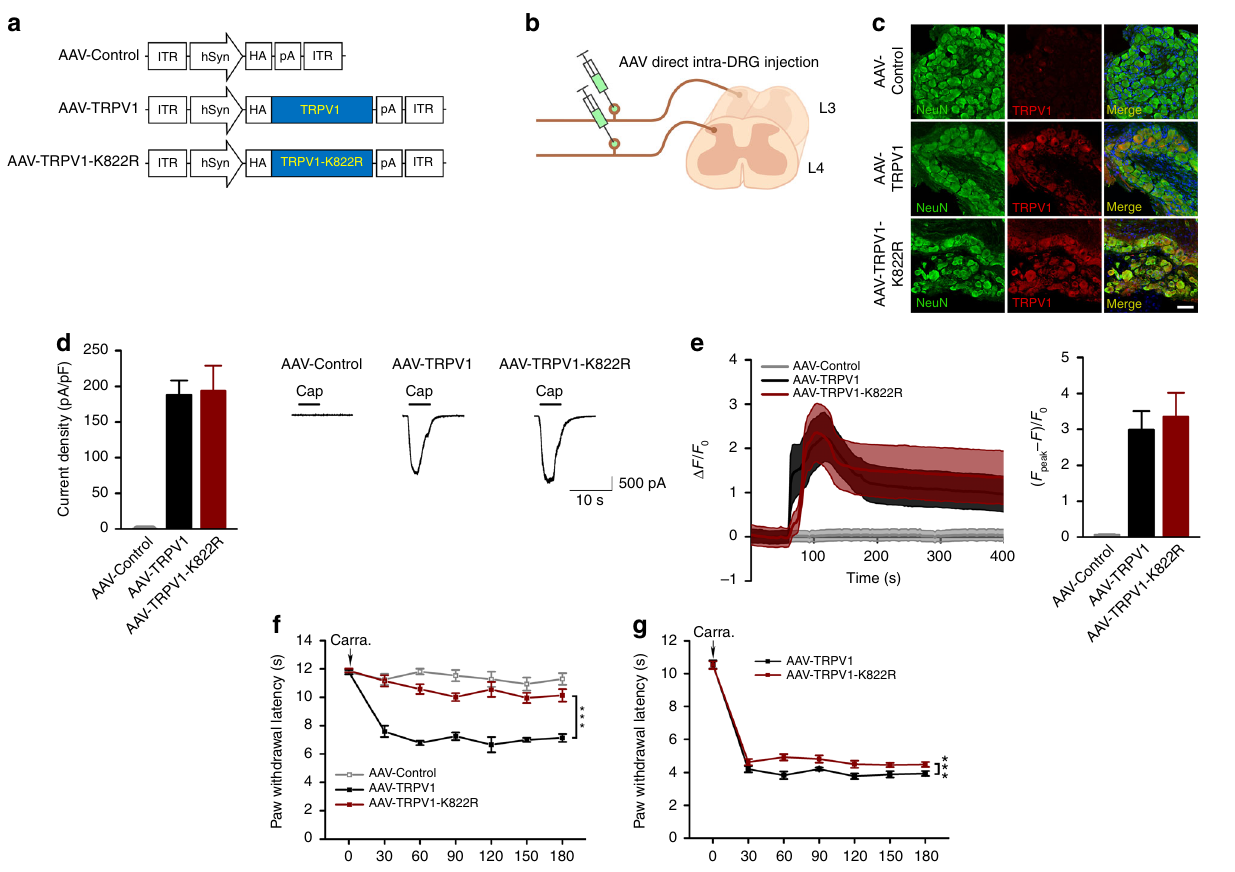
Fig. 9 Essential role of TRPV1 SUMOylation in in fl ammatory thermal hyperalgesia. a Schematic diagram for the design of AAV-Control, AAV-TRPV1, and AAV-TRPV1-K822R. b Diagram for AAV viral infection into L3 – L4 DRG of TRPV1 − / − mice. The viruses (2 μ l) were directly injected into the DRG. c The expression of TRPV1 in the left L3-L4 DRG of TRPV1 − / − mice 4 weeks after the injection of AAV-Control, AAV-TRPV1, and AAV-TRPV1-K822R. DRG sections were stained with antibodies against TRPV1 (red) and NeuN (green). d Whole-cell currents at − 60 mV evoked by capsaicin (1 μ M) in neurons isolated from left L3-L4 DRG of TRPV1 − / − mice that received the injection of AAV-Control, AAV-TRPV1, or AAV-TRPV1-K822R, as indicated, 4 weeks prior to DRG dissection. Representative traces (right) and quanti fi cation of current densities (left) are shown. The current densities are: AAV-Control, 0.58 ± 0.09 pA/pF ( n = 10); AAV-TRPV1, 187.5± 18.5 pA/pF ( n = 11); AAV-TRPV1-K822R, 194.3 ± 33.4 pA/pF ( n = 13). e Capsaicin-evoked Ca 2 + transients in neurons as prepared in d . Cells were loaded with Fluo-4 and then images taken while capsaicin (1 μ M) was applied at 60 sec. Time courses (left) and peak responses to capsaicin (right) are shown as Δ F / F 0 , where F is fl uorescence at a given time point, F 0 is the baseline fl uorescence, and Δ F = F − F 0 . The peak values are: AAV-Control (gray), 0.06 ± 0.02 ( n = 21); AAV-TRPV1 (black), 2.99 ± 0.52 ( n = 14); AAV-TRPV1-K822R (wine) = 3.35 ± 0.67 ( n = 9). f AAV- TRPV1-K822R failed to rescue in fl ammatory thermal hyperalgesia in TRPV1 − / − mice. At 4 weeks after the injection of AAV-Control, AAV-TRPV1, and AAV-TRPV1-K822R in the left L3-L4 DRG, the TRPV1 − / − mice were subject to the carrageenan edema model. The paw withdrawal latency (PWL) was measured as in Fig. 3e. Only AAV-TRPV1, but not AAV-Control or AAV-TRPV1-K822R, rescued thermal hyperalgesia induced by carrageenan administration to the hindpaws ( n = 5 per group). *** P < 0.0001, AAV-TRPV1 vs. AAV-TRPV1-K822R. g AAV-TRPV1-K822R exhibited weak dominant negative effect on in fl ammatory thermal hyperalgesia in wild-type mice. Similar to f but AAV-TRPV1 and AAV-TRPV1-K822R were injected to the left L3 – L4 DRG of wild type mice. At 4 weeks after the injection, mice were subject to the carrageenan edema model and PWL was measured by